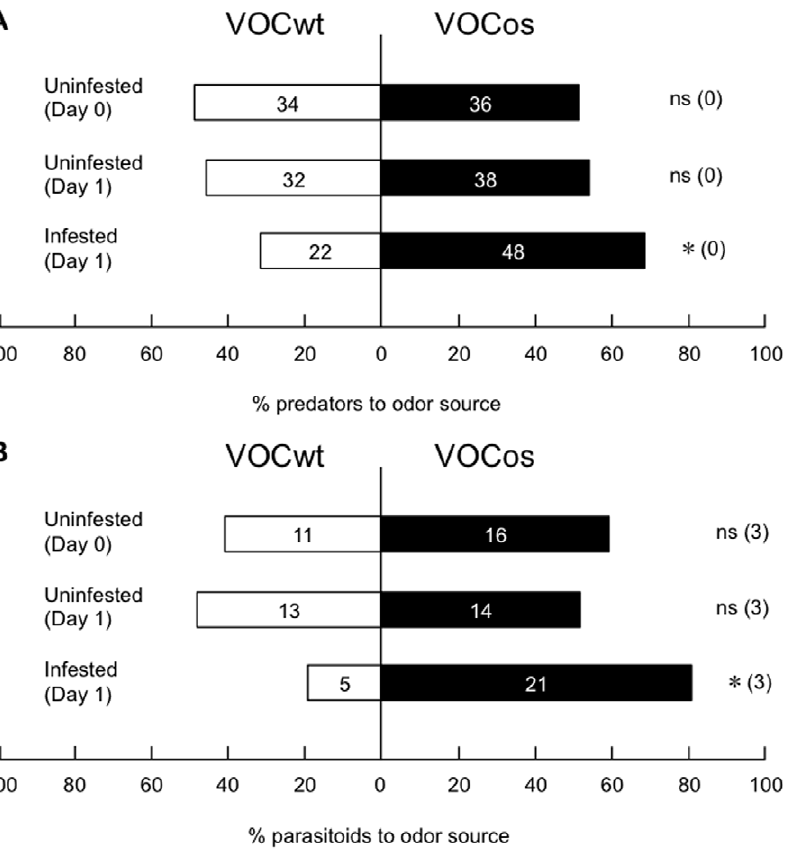
Figure 4. Indirect defenses of VOCos/VOCwt-exposed plants. ( A ) Olfactory response of carnivorous predatory mites ( P. persimilis ) when offered VOCwt-exposed vs. VOCwt-exposed lima bean receiver plants. ( B ) The flight responses of parasitoids ( C. kariyai ) when offered VOCwt- exposed vs. VOCos-exposed receiver maize plants. The receiver plants were assessed immediately (day 0) after exposure to either VOCwt or VOCos, and subjected to one day post-herbivory by T. urticae ( A ) or M. separata ( B ). Uninfested plants incubated for 1 day after VOC exposure served as controls. The bar represents the overall percentages of arthropods choosing either of the odor sources. The figures in parentheses represent the numbers of predators that did not choose either odor source (no choice subjects). A binomial test was conducted to evaluate whether the result in each experiment differed from the null hypothesis in which predators showed a 50:50 distribution between the two odor sources (*: P , 0.05, ns: P . 0.05).